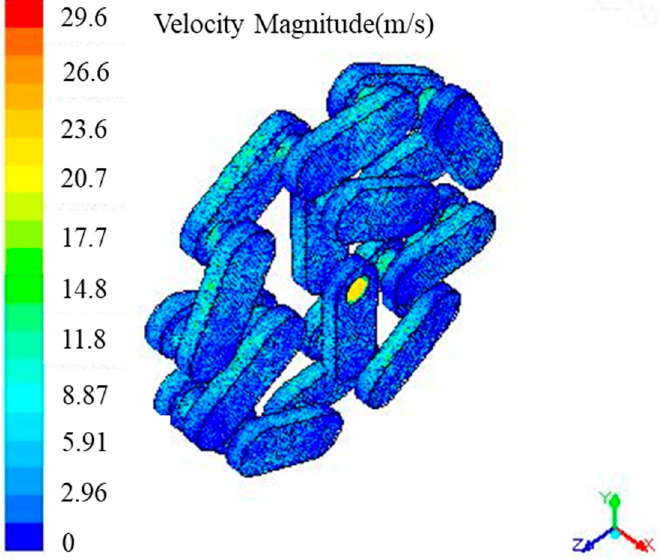
Figure 6. Velocity distribution results of steady flow plate when inlet is 0.11 MPa and outlet is 0.1